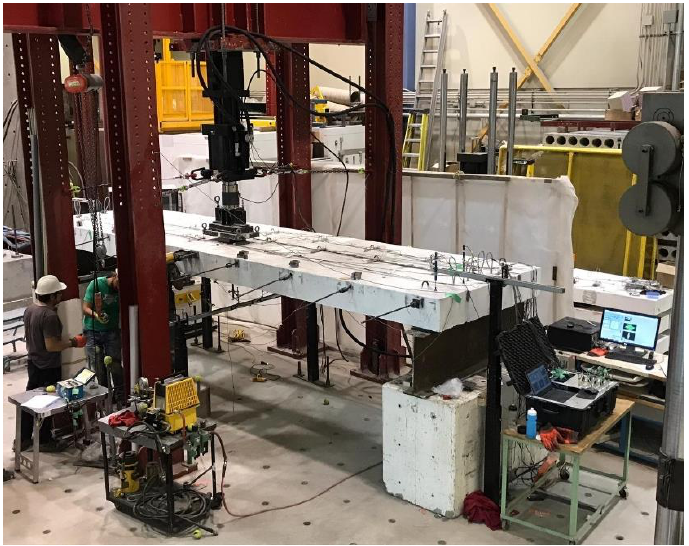
Figure 3. Load distribution test setup (vertical load applied at an interior girder).